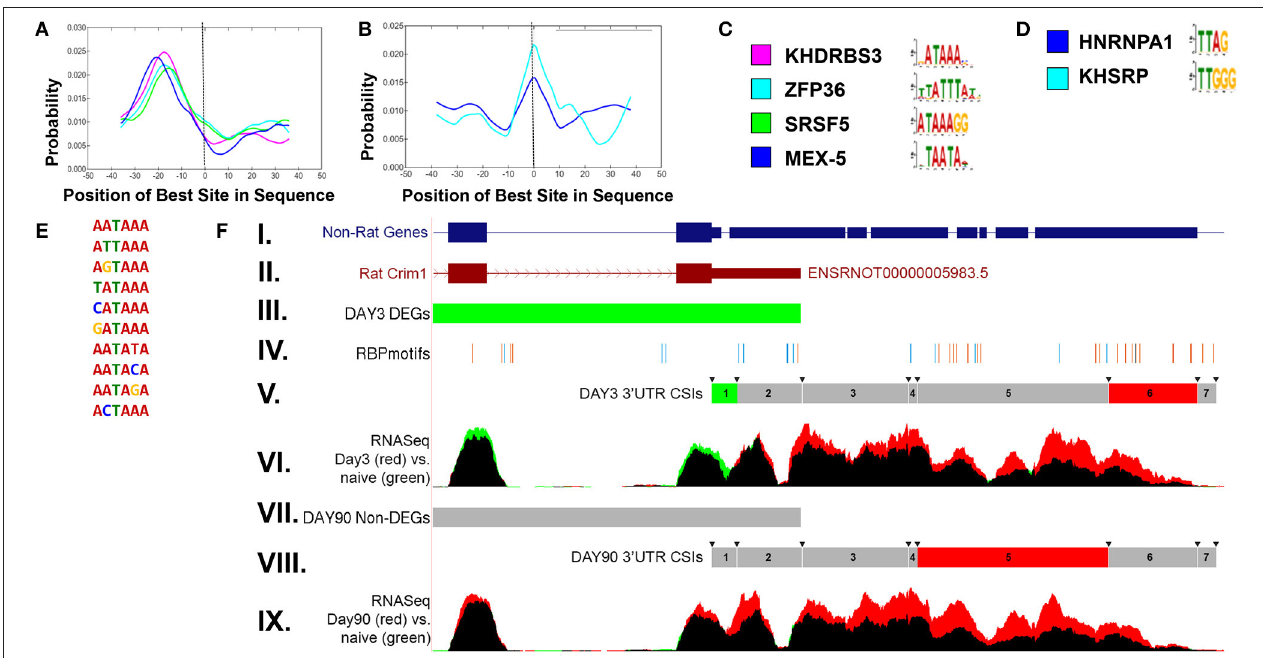
FIGURE 6 | Enriched RNA binding motifs for differentially expressed CSIs in rat sciatic nerve transection. (A) shows enriched RNA binding protein (RBP) motifs upstream of significantly changed CSI sites. The location ( − 30 to − 10) is consistent with previously reported results (Beaudoing et al., 2000). (B) shows enriched RBP motifs overlapping the boundaries of significantly changed CSI sites. The corresponding upstream and overlapping motif patterns are shown in (C,D) , respectively. The enriched upstream motifs (A) are consistent with the most prevalent polyadenylation sites (E) . (F) shows an example of the CSI-UTR analysis within the rat Crim1 gene. In this case, the rat Crim1 UTR annotation (subpanel II) is significantly shortened when compared to Crim1 homologs (subpanel I). Subpanels III and VII indicate the differential expression status at the gene level (using cuffdiff) for day 3 and day 90 vs. naïve, where red represents significant up-regulation, green represents significant down-regulation (as seen in day 3 vs. naïve, subpanel III) and gray represents a non-significant change (as seen in day 90 vs. naïve, subpanel VII). The location of RBP motifs from (C,D) are shown in subpanel IV, and tend to cluster around the CSI interval boundaries, which are indicated by the arrows in subpanels V and VIII. The CSI usage status for each of the seven Crim1 CSIs is shown in subpanels V and VIII, where red represents a significant increase in utilization, green represents a significant decrease in utilization, and gray represents a non-significant difference. Using the information from subpanels V and VIII along with the mapped RNASeq reads in panels VI and IX, we can infer there are likely three separate 3 ′ UTR isoforms present at both day 3 and day 90, with the short form terminating after CSI 2, the intermediate form terminating after CSI 4, and the long form terminating after CSI 6. In this case, there is not any sequence based evidence for extension of the 3 ′ UTRs into CSI 7. These results for panel (F) indicate that in addition to the differential down regulation of Crim1 at day 3, that Crim1 isoforms are typically elongated in the UTR at both experimental day 3 and day 90 when compared to